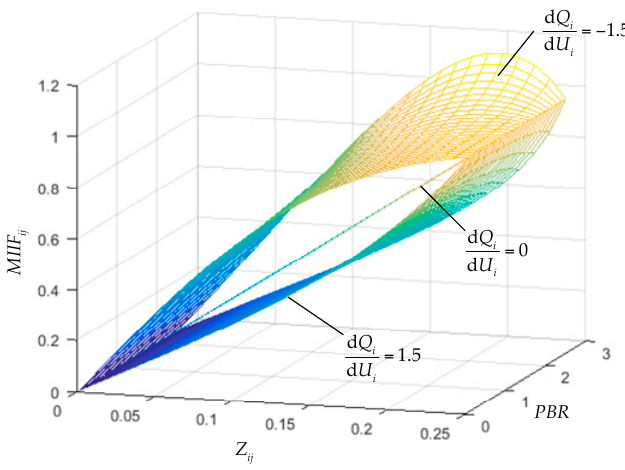
Figure 7. MIIF versus power base ratio and mutual impedance.